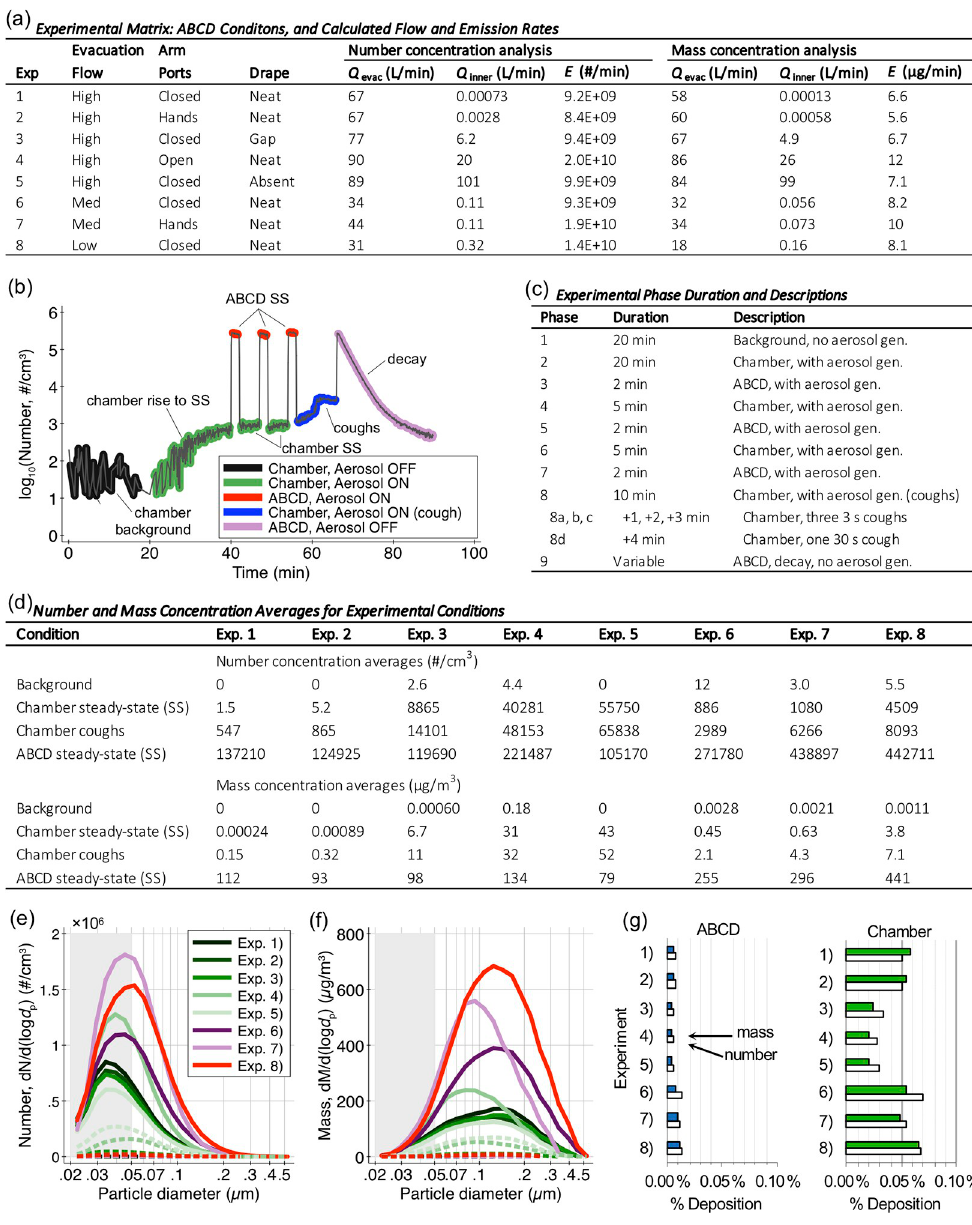
Fig 2. ABCD experimental conditions and summary. (a) Description of experimental test conditions and fitted flow and emission rates; (b) time series of typical experimental measurements (using Exp. 6 as an example); (c) description of experimental phases corresponding to time series in (b); (d) average number and mass concentrations in major experimental phase groupings; average (e) size and (f) mass distributions in ABCD and 1 m 3 environmental chamber during steady state phases; (g) estimate of percentage of aerosol lost to deposition in ABCD and environmental chamber during steady state phases.